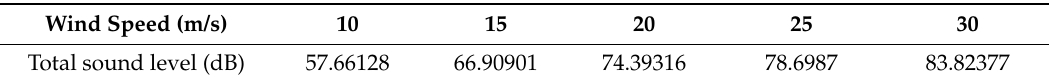
Figure 5. Frequency response curves for different wind speeds. Table 2. Total sound level for different wind